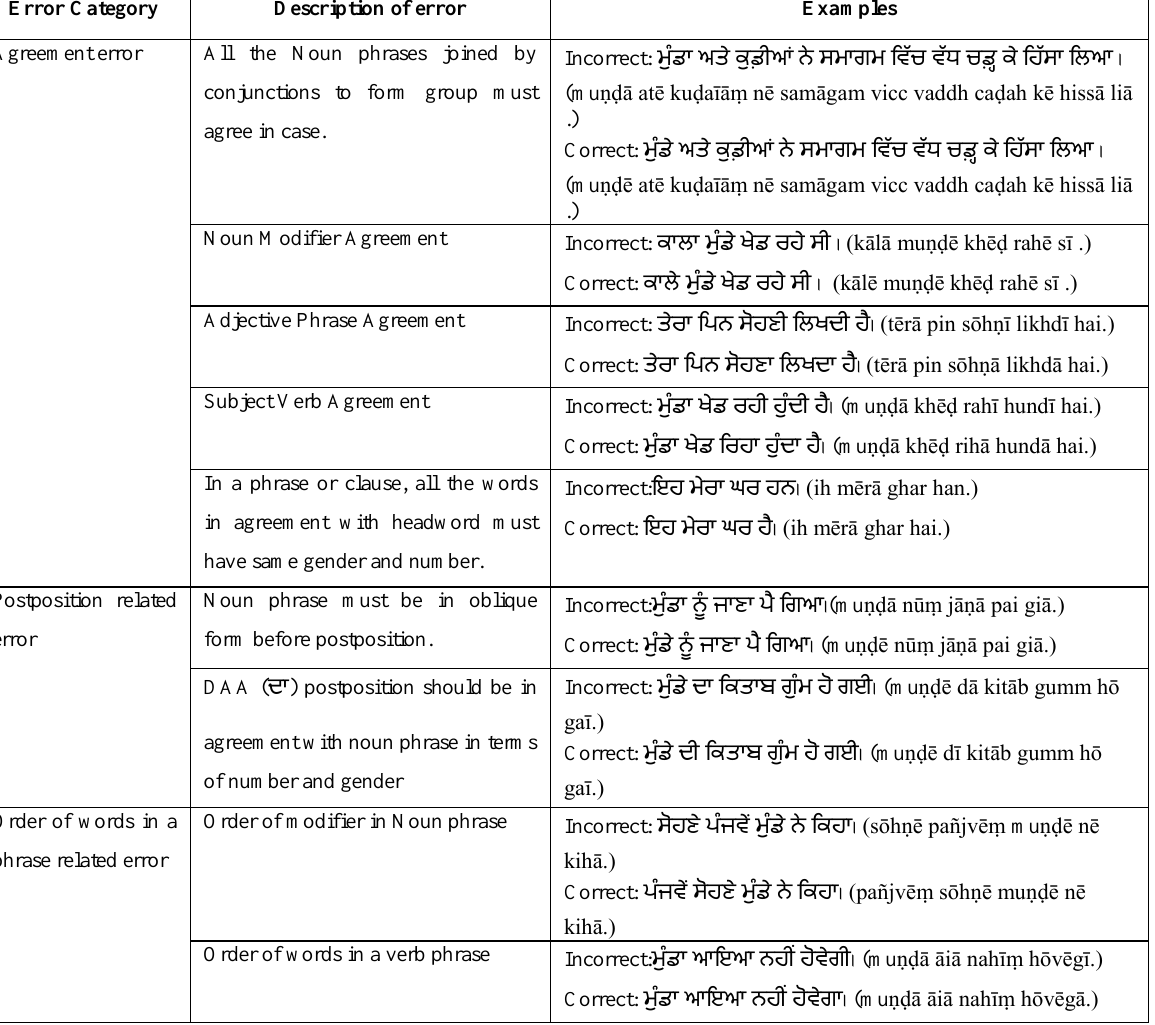
Table 1: Various Error types handled by the system Description of